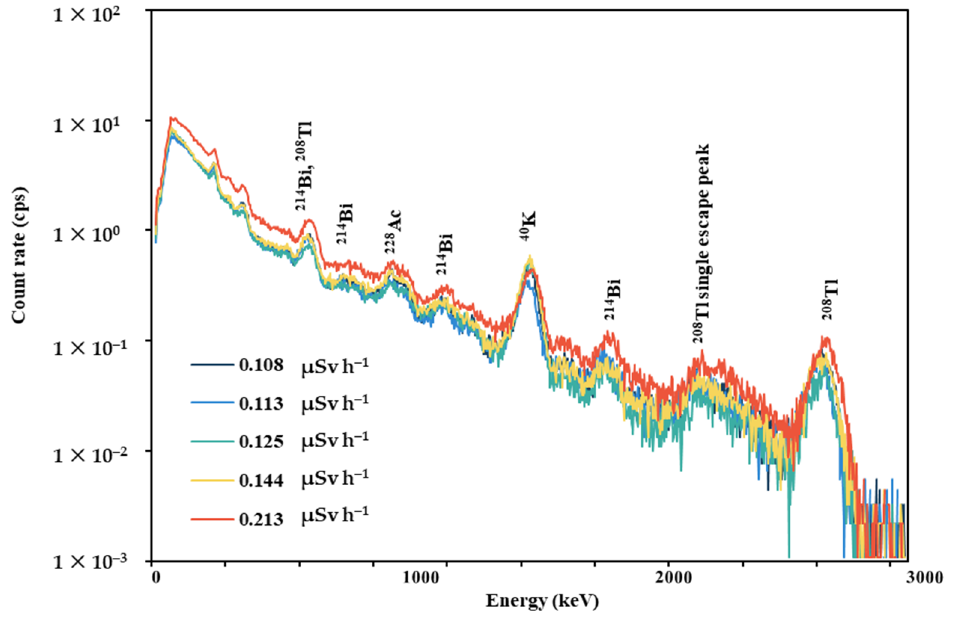
Figure 8. Gamma-ray pulse-height distributions measured at hotspot locations obtained from spot measurements.